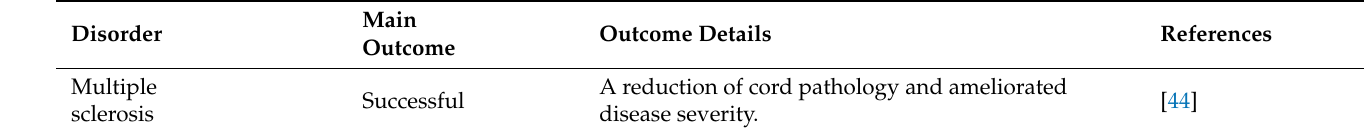
Table 3. Therapeutic experimental studies applying FMT in autoimmune diseases. The table summarizes experimental studies in which animal donor stool was applied to ameliorate the onset, slowdown the progression or suppress the symptoms of autoimmune diseases in animal models, namely multiple sclerosis, rheumatoid arthritis, Sjogren’s syndrome and systemic lupus erythematosus. The table summarizes the main outcome of FMT application and highlights interesting outcome